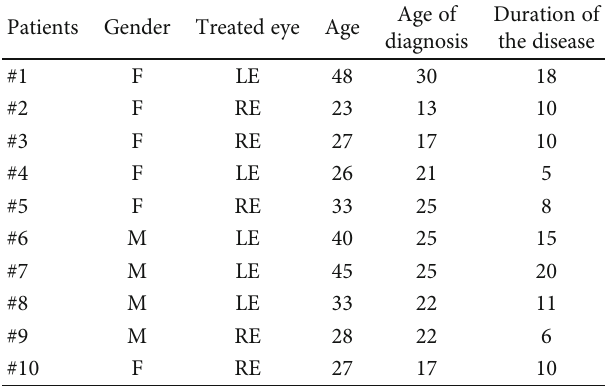
Table 2: Visual acuity measured before IV injection, three and six months after. Description of the number of letters won per patient (patient #1 to